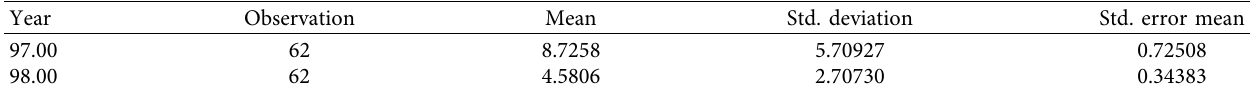
Table 14: SPSS software outputs for testing the difference in the average number of